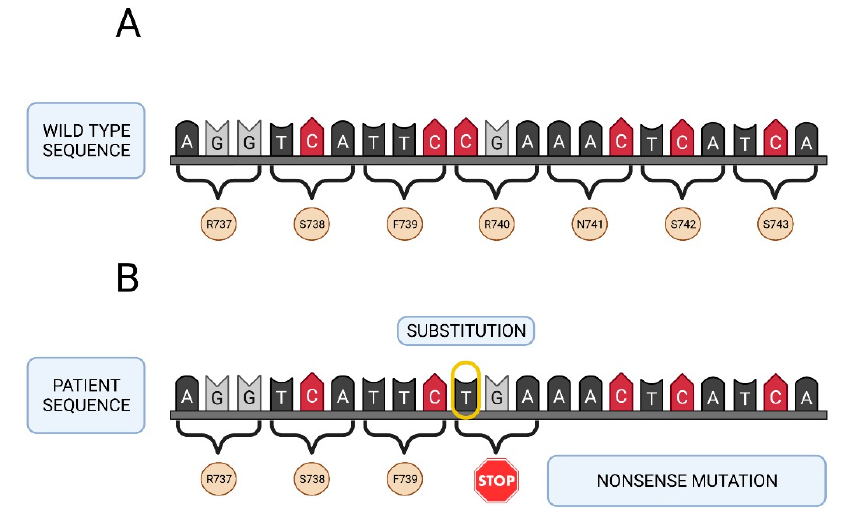
Figure 2. Genetic map of the F5 gene of patient A. ( A ) Native sequence. ( B ) Sequence of the patient with the Arg740* mutation (premature stop codon, nonsense mutation). Created in Biorender.com (accessed on 6 September 2021).